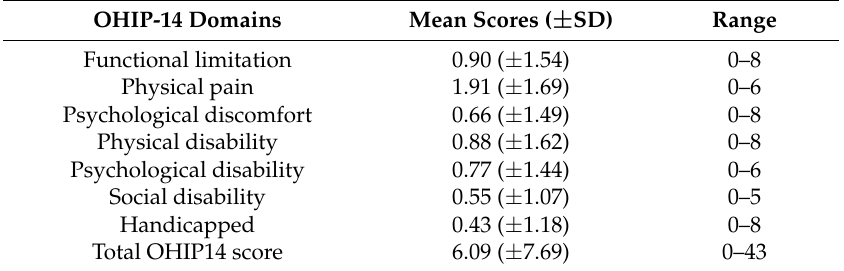
Table 4. Mean and range values for each domain and the total OHIP-14 scores ( N = 138).